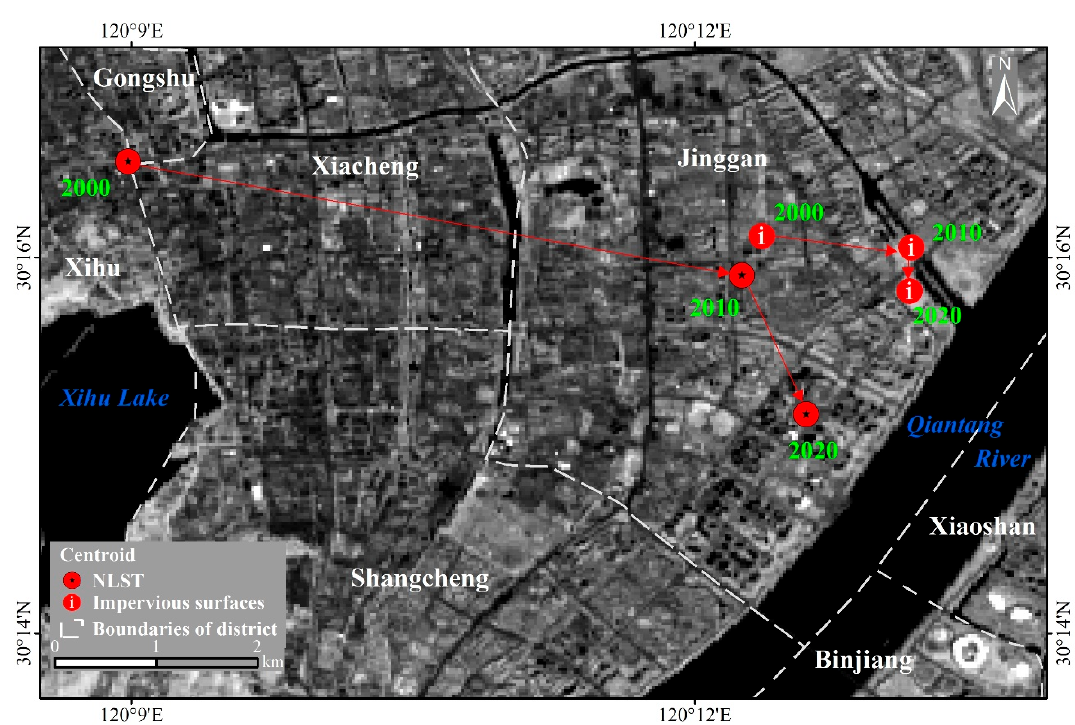
Figure 8. Centroid movements for NLST and impervious surfaces in Hangzhou City from 2000 to 2020. The background represents the band 5 (near infrared) of the mosaic Landsat-8 OLI imagery used for the classification.